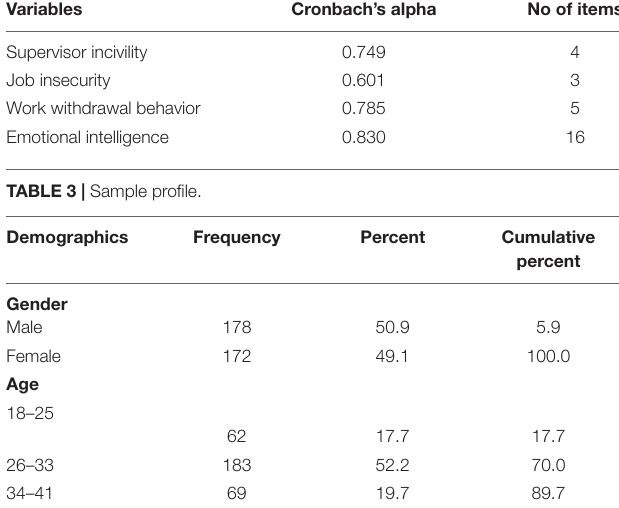
TABLE 2 | Reliability statistics.